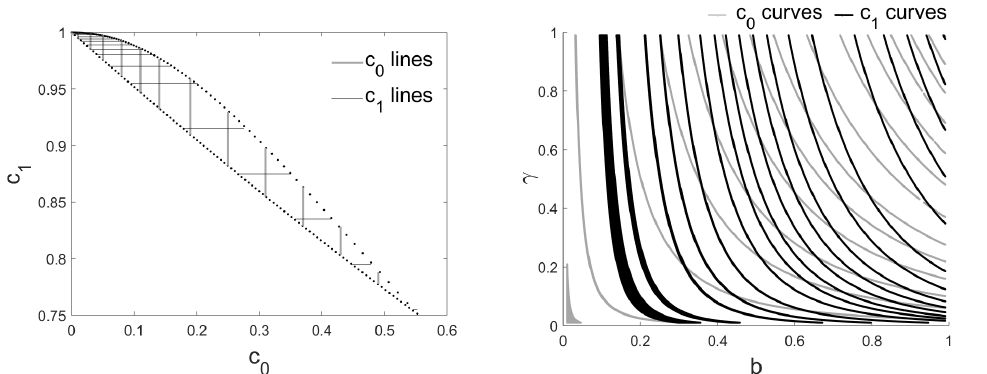
Figure 7. Coordinate lines of the map ( Λ h ) − 1 defined in